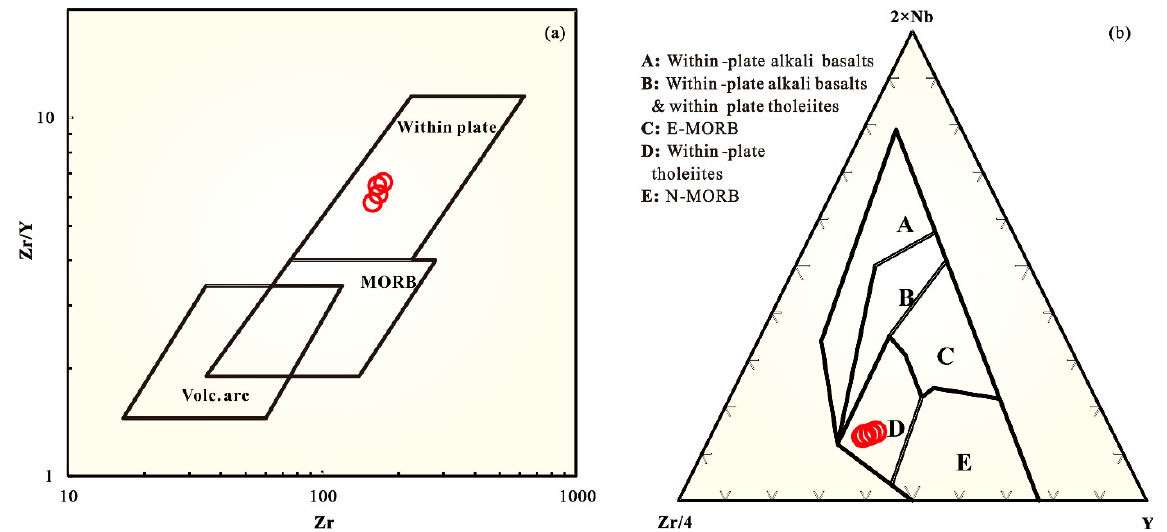
Figure 9. Tectonic environment discrimination diagrams for the hornblende gabbro samples of the Baogeqi gabbro pluton: ( a ) Zr/Y vs. Zr [62] and ( b ) Nb×2-Zr/4-Y [63].